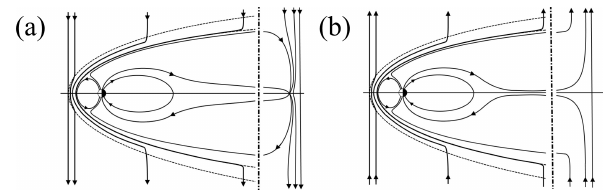
Figure 1. Partially closed magnetospheric model for (a) southward and (b) northward